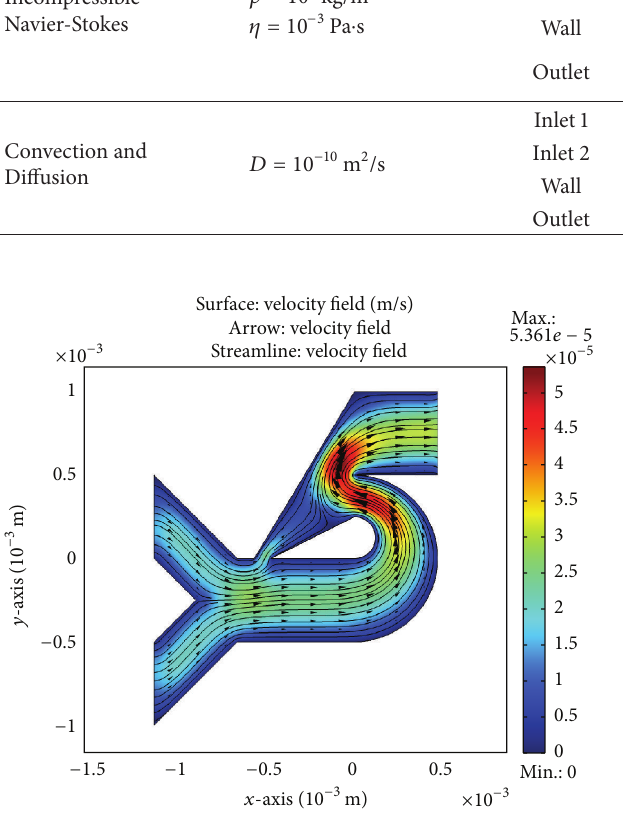
Figure 3: Velocity field plot along the micromixer with one mod- ified tesla element (Comsol simulation).